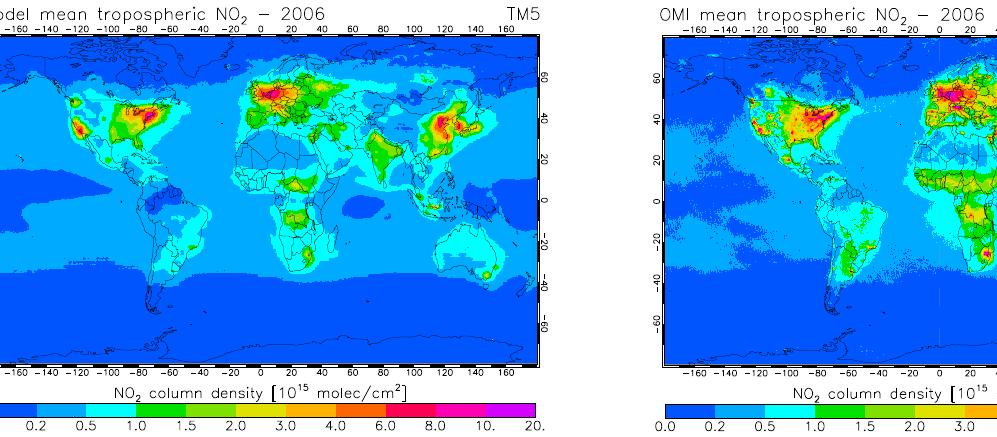
Fig. 9. TM5 annual mean tropospheric NO 2 column density versus OMI.